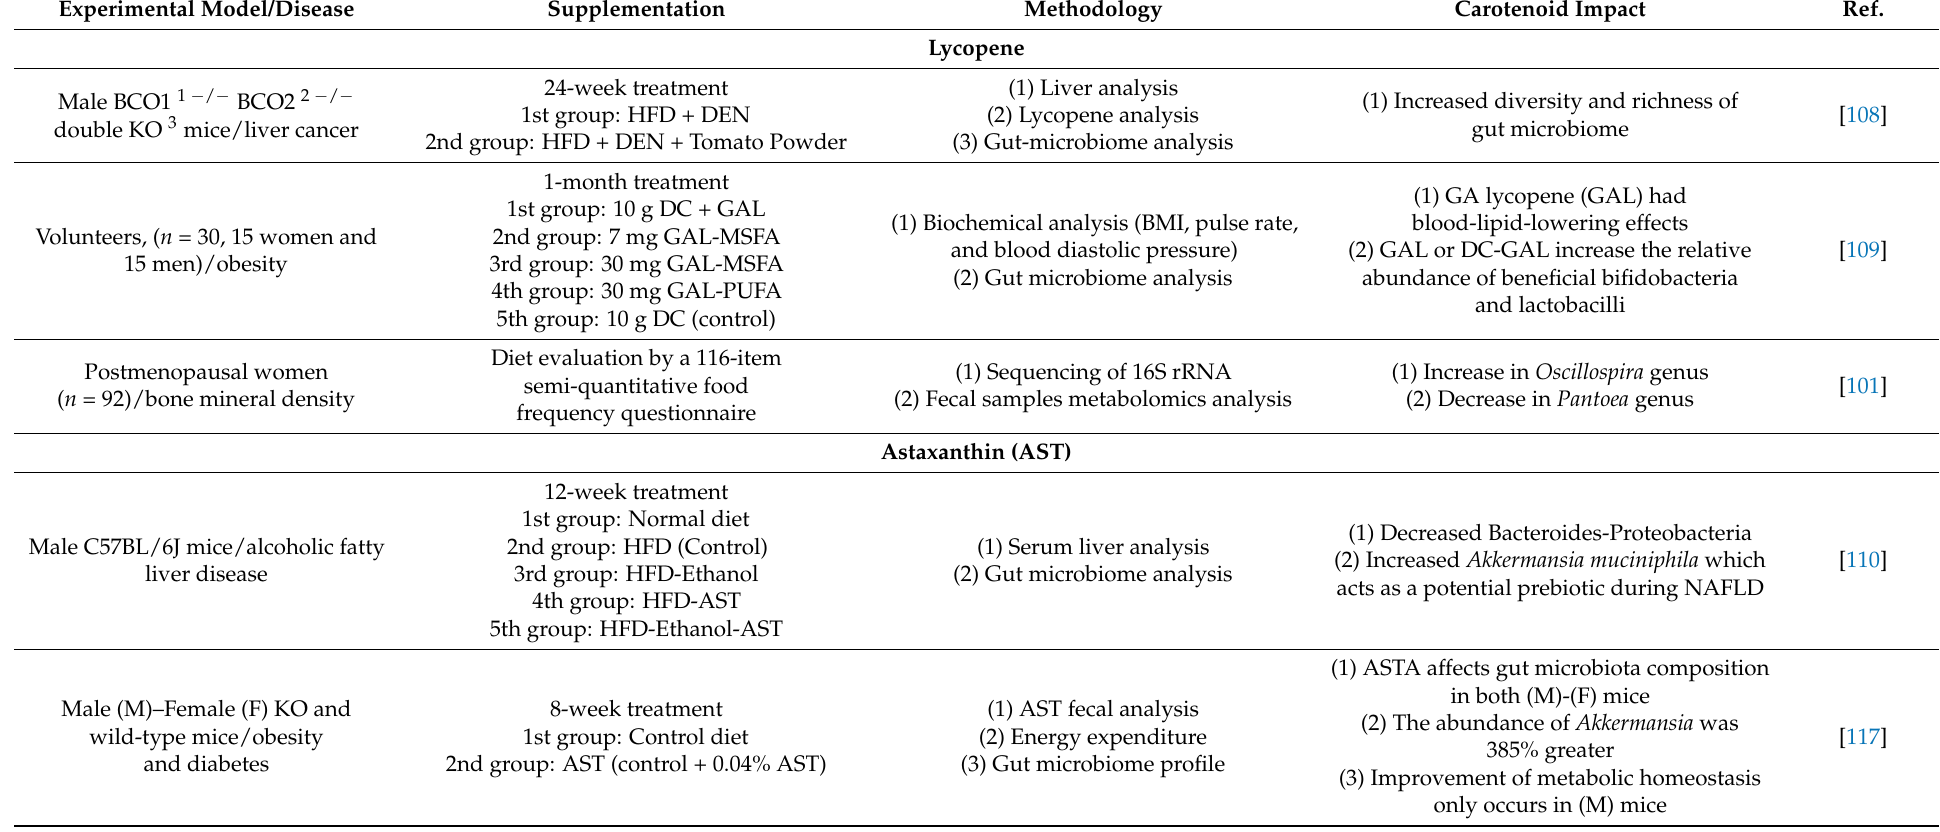
Table 2. Recent studies highlighting carotenoid and gut microbiota interplay through their potential impact in various intestinal diseases and metabolic